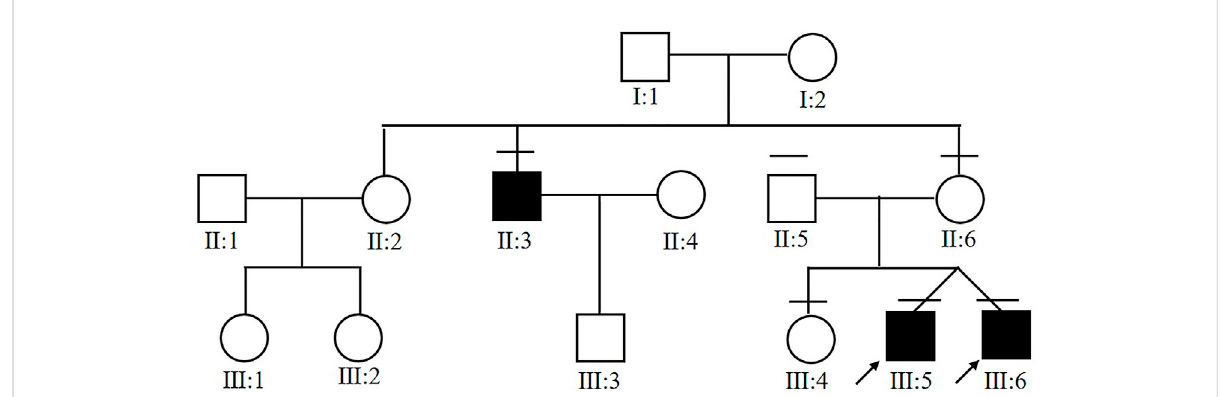
FIGURE 1 Pedigree chart of the affected family. Arrow indicates proband. Black fi lled symbols indicate patients.